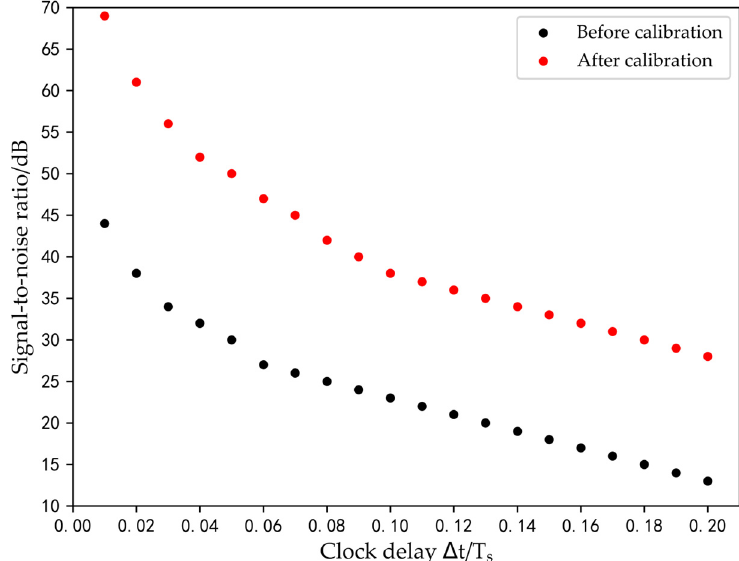
Figure 8. Changes in SINAD for a two-channel TIADC.